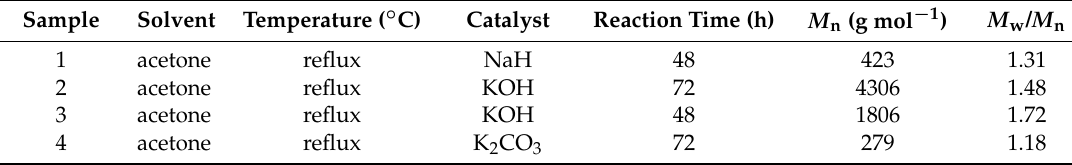
Table 1. Synthesis of UPTHF with different polymerization